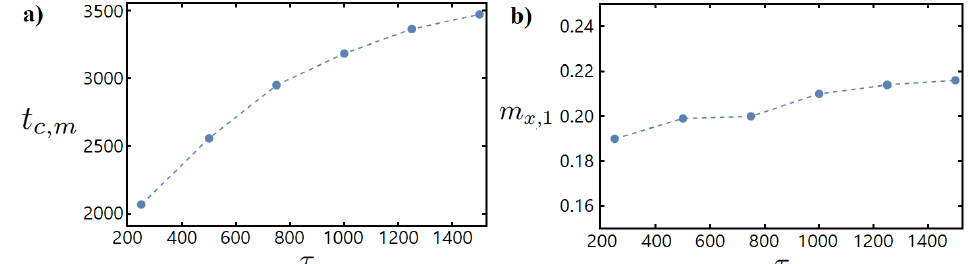
( τ ) is chosen 0 as a x ,1